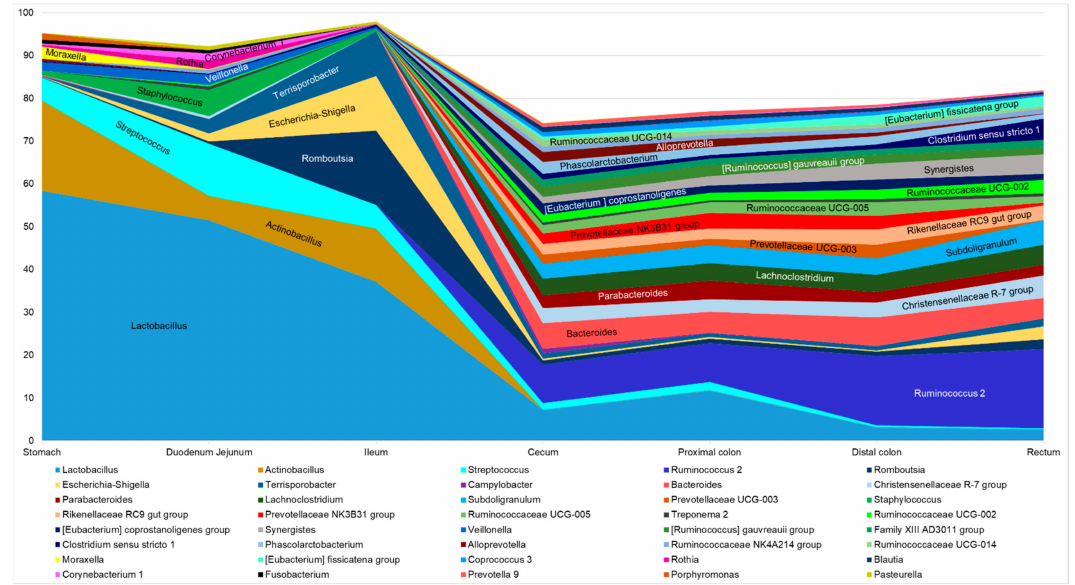
Figure 4. Mean relative abundance of the main bacterial genera along the GIT of weaning piglets.